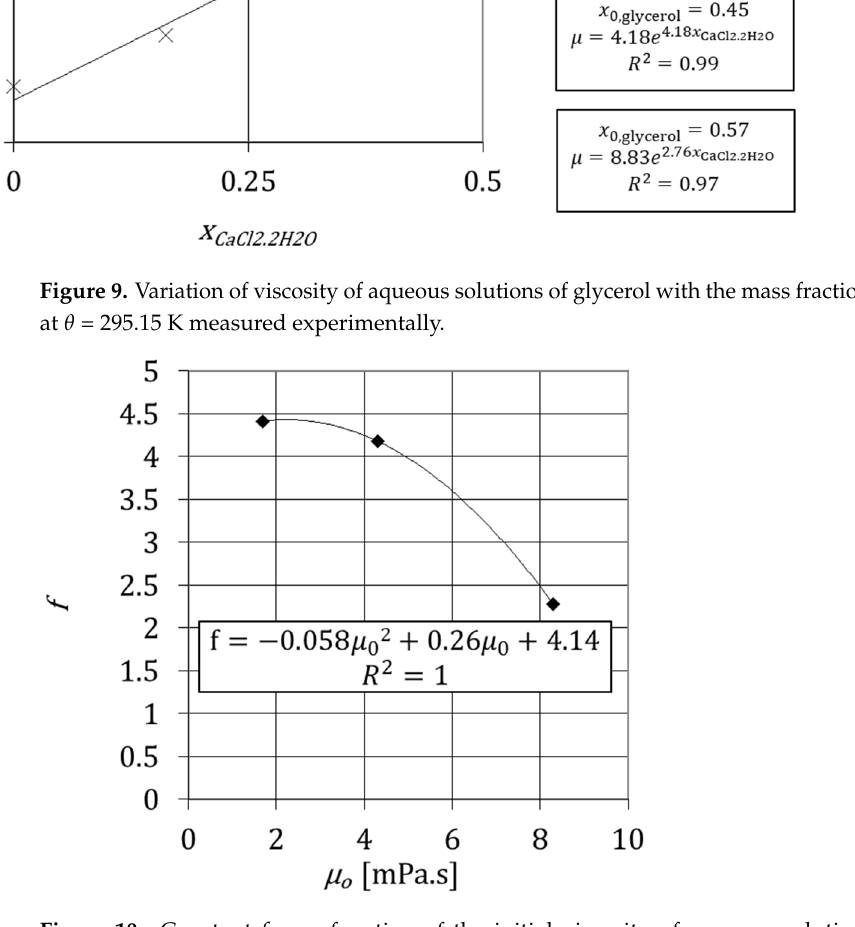
Figure 10. Constant f as a function of the initial viscosity of aqueous solutions of glycerol at θ = 292.15 K.